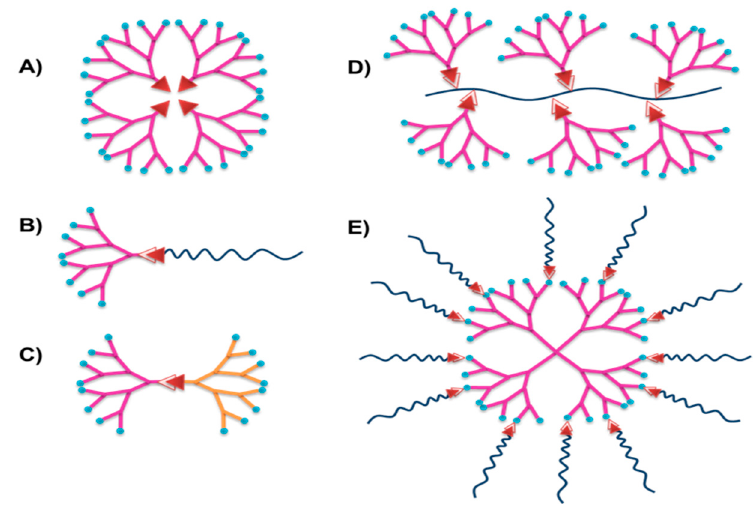
Figure 4. Different architectures of dendritic polymers: ( A ) dendrimer-type; ( B ) linear-dendritic block copolymer; ( C ) Janus dendritic polymer; ( D ) dendronized polymer; and ( E ) dendritic multiarm copolymer. Focal point of dendrimer (Red); branches of dendrimer (pink); terminal groups of dendrimer (blue); main polymeric chain (black); another type of dendron with different functional groups (orange).